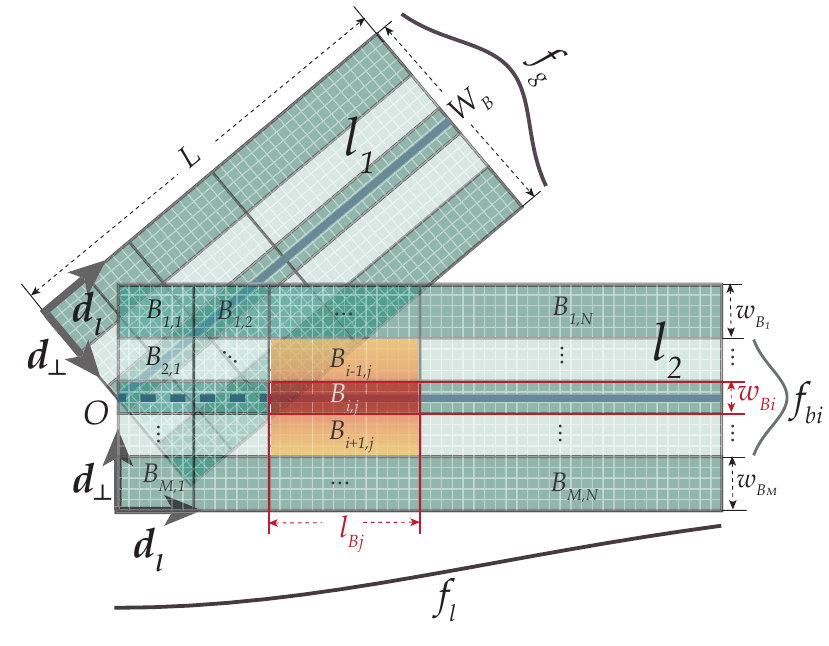
Figure 4. LIL local feature description.